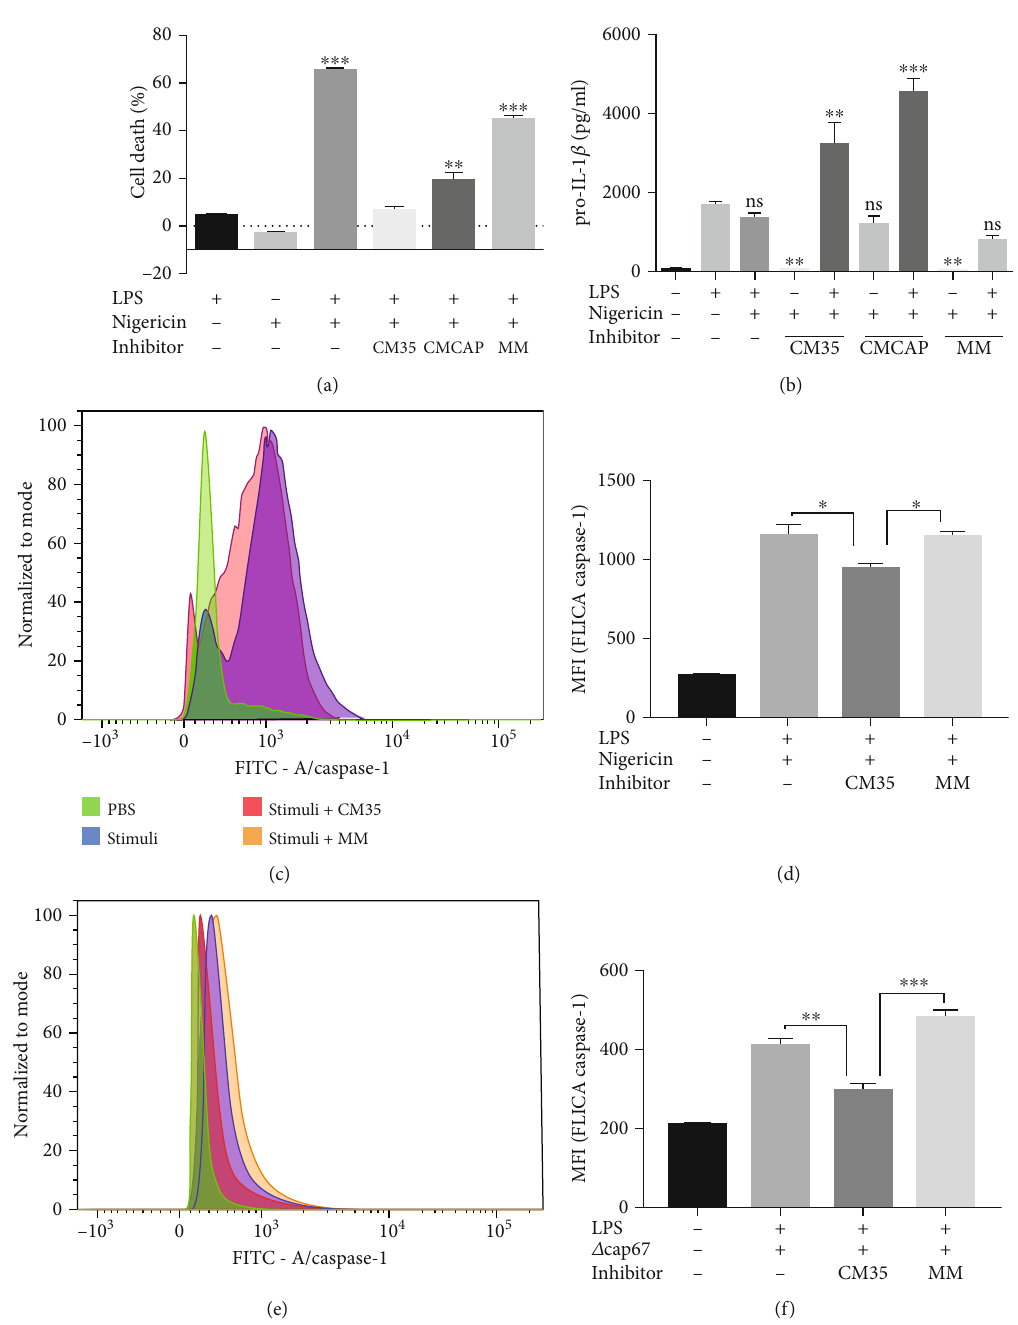
Figure 3: 1 kDa CM35 inhibits caspase-1 activation, promotes pro-IL-1 β accumulation, and inhibits cell death. (a) LDH release from supernatants of BMMs stimulated with LPS (500ng/ml) and/or nigericin (20 μ M), with or without inhibitors (10% v / v ). The medium group was utilized as negative control (0% of cell death) and the DMSO (15%) group was used as positive control (100% of cell death). (b) pro-IL-1 β production measured from cell lysates of BMMs stimulated with LPS (500ng/ml) and/or nigericin (20 μ M), with or without inhibitors (10% v / v ). (c – f) BMMs stimulated with LPS (500ng/ml) and nigericin (20 μ M) or Δ cap67 (MOI 5:1), with or without inhibitors, were analyzed for caspase-1 activation (FLICA). LDH release was measured by colorimetric assay (a), cytokine was measured by ELISA (b), and caspase activation was measured by fl ow cytometry. (c, d) LPS and nigericin or (e, f) Cap67 was used as stimuli, and the mean fl uorescence intensity (MFI) was assessed (d, f). Statistical analysis was performed by one-way ANOVA, where ns: not signi fi cant; ∗ P ≤ 0 : 033 ; ∗∗ P ≤ 0 : 002 ; ∗∗∗ P ≤ 0 : 001 . Comparisons were made with the LPS only group (a,